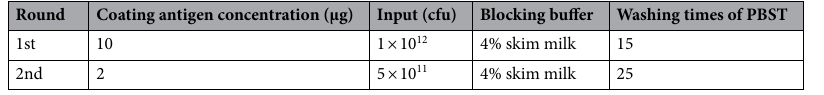
Table 1. Panning strategy for isolating specific antibodies against the SARS-CoV-2 N protein.